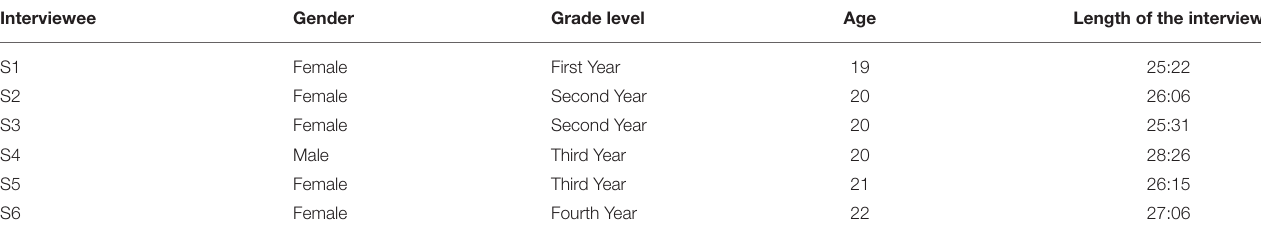
TABLE 1 | Information about the Interviewees and the Length of the Interviews.